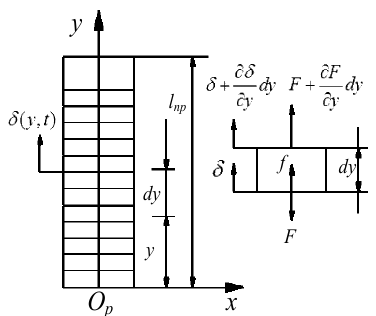
Figure 5. Free vibration model of piezoelectric stack.